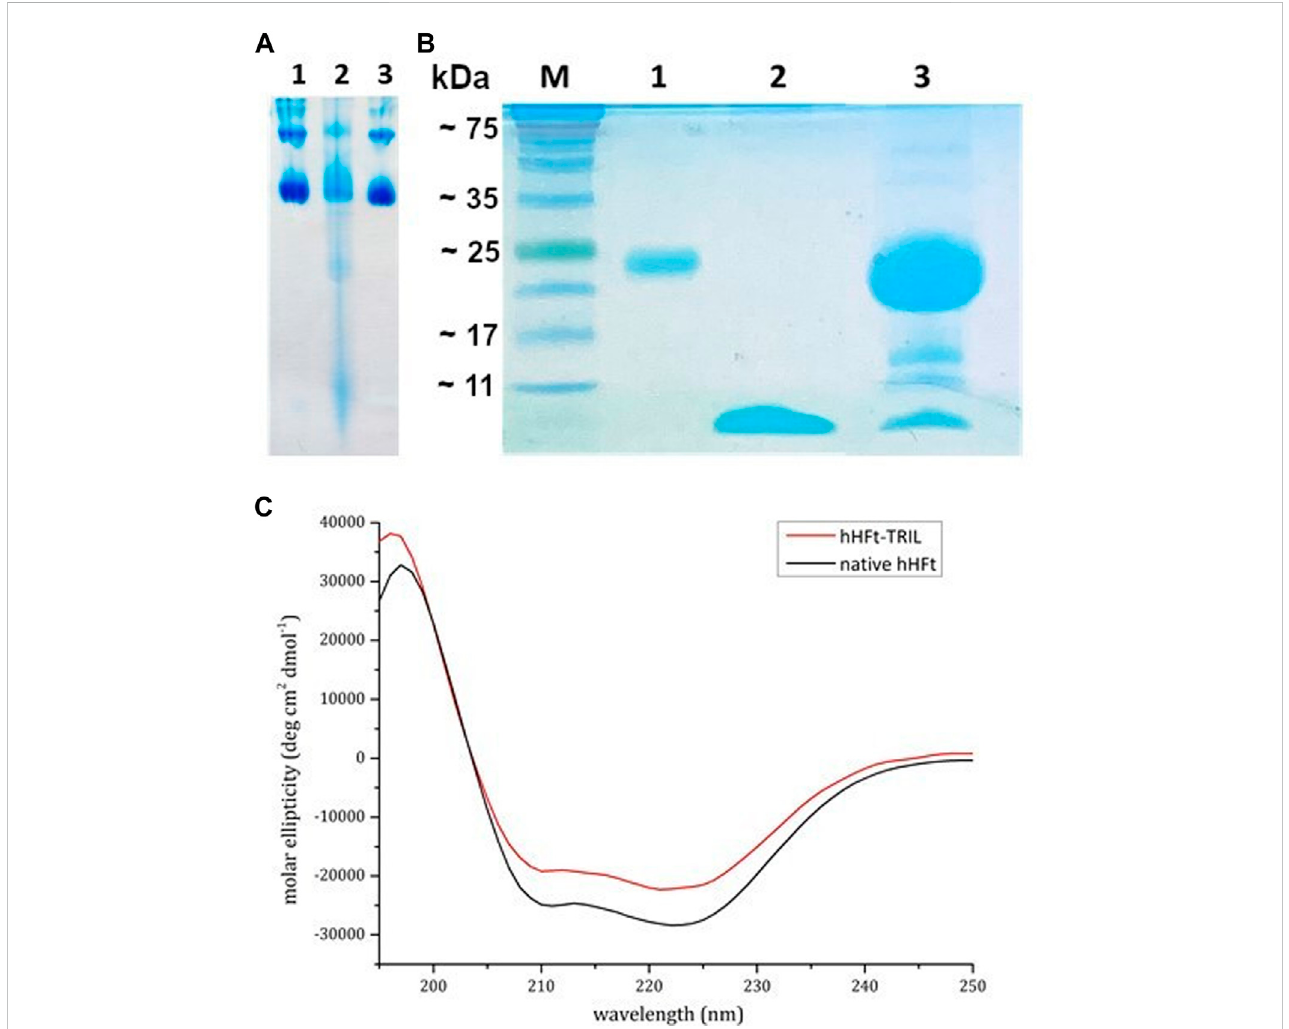
FIGURE 6 ElectrophoreticandspectroscopicanalysisofTRIL-hHFt: (A) GelelectrophoresisundernativeconditionsofhHFt, lane1 referencehHFtand lane2 TRIL- hHFt after the encapsulation. (B) 15% SDS-PAGE gel of and treated samples: M proteins marker, lane 1 reference hHFt, lane 2 TRIL, lane 3 TRIL-hHFt after the encapsulation. (C) CD spectra of native hHFt (black line) and of TRIL-hHFt (red line) in 20 mM Tris-HCl pH